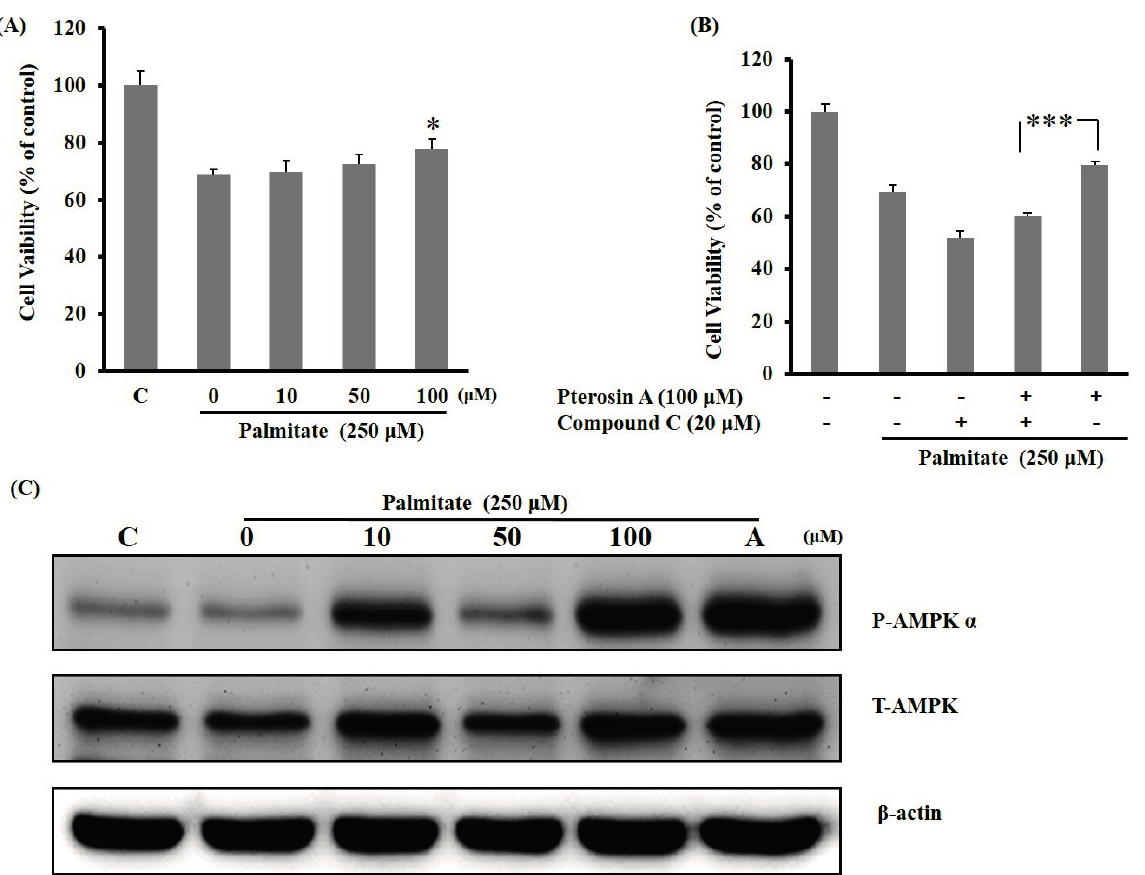
Figure 7. Effects of pterosin A on palmitate-induced lipotoxicity and AMPK expression in RINm5F cells. ( A ) Cell viability on cotreatment with various doses of pterosin A and palmitate (250 μ M) for 24 h; ( B ) The cells were pretreated with Compound C (20 μ M) for 2 h, followed by cotreatment with plamitate (250 μ M) with and without pterosin A for 24 h; ( C ) Western blot analysis of total and phospho-AMPK (A: 5-aminoimidazole-4- carboxamide ribonucleotide (AICAR) was used as a positive control). Data are presented as mean ± SEM. * p < 0.05; *** p <